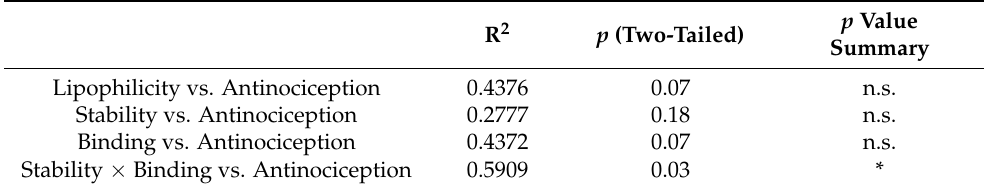
Table 2. Summary of the statistical values of the Pearson correlation performed on the scatter plots in Figure 3. n.s. denotes not significant, * p <